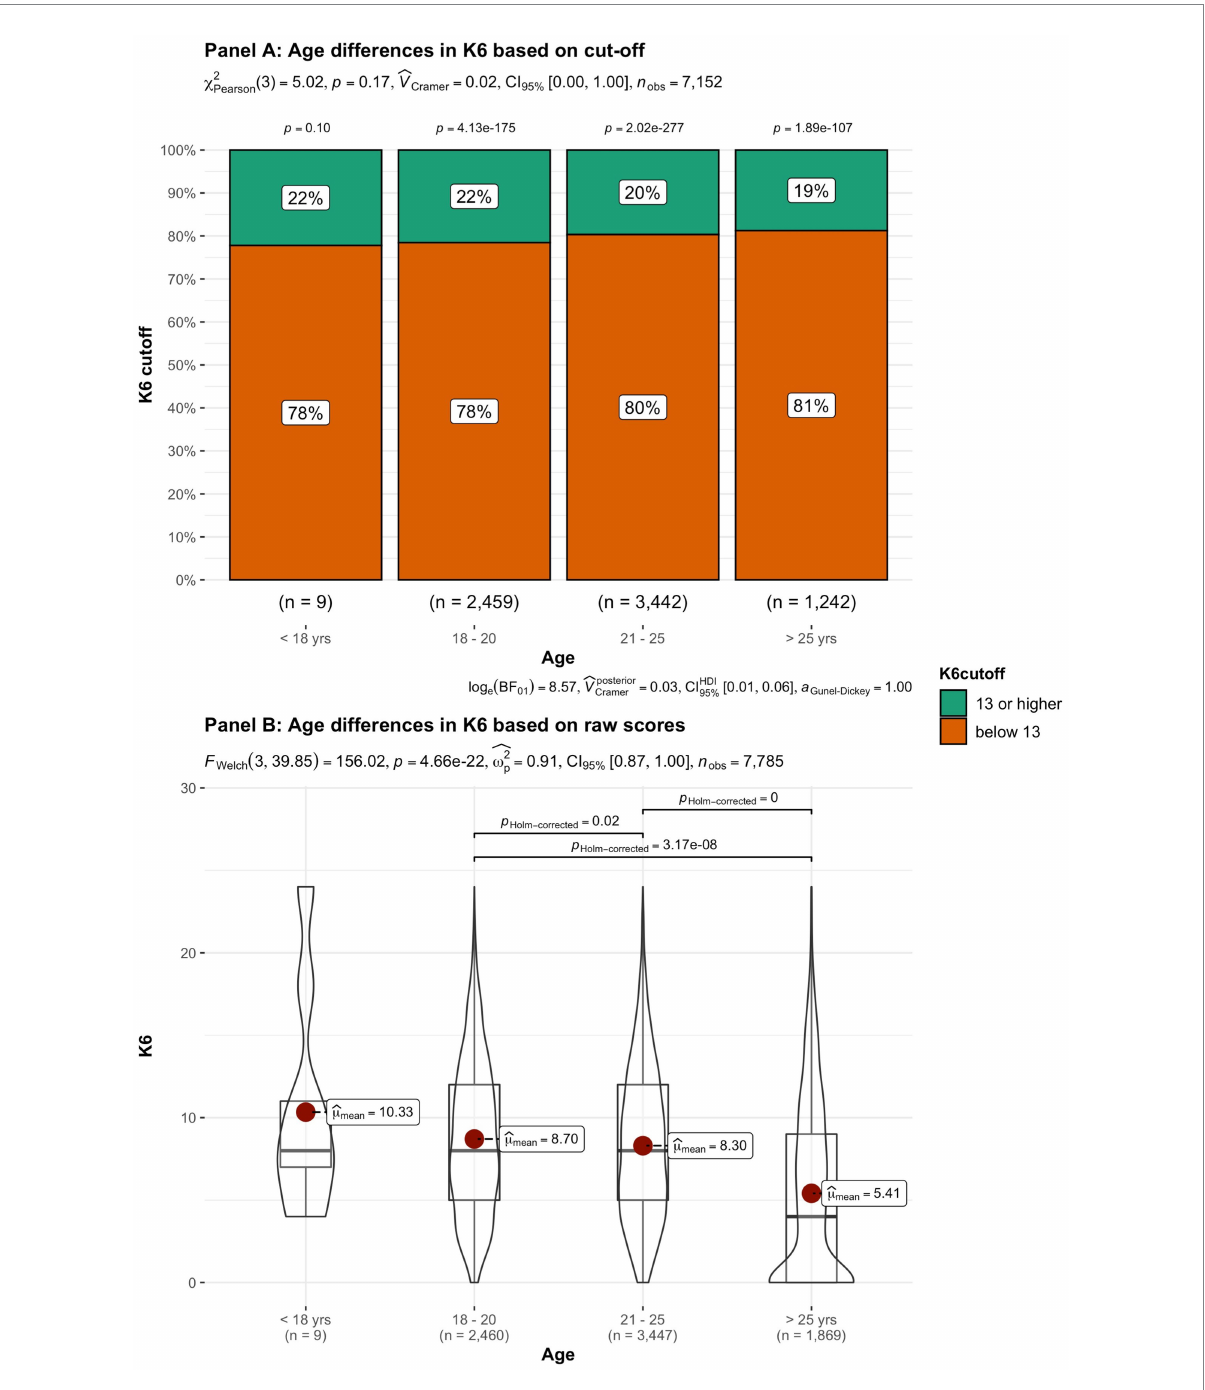
FIGURE 10 Summated scores on the K6 (indicator of mental illness and considered as a cutoff variable) across student subgroups in terms of